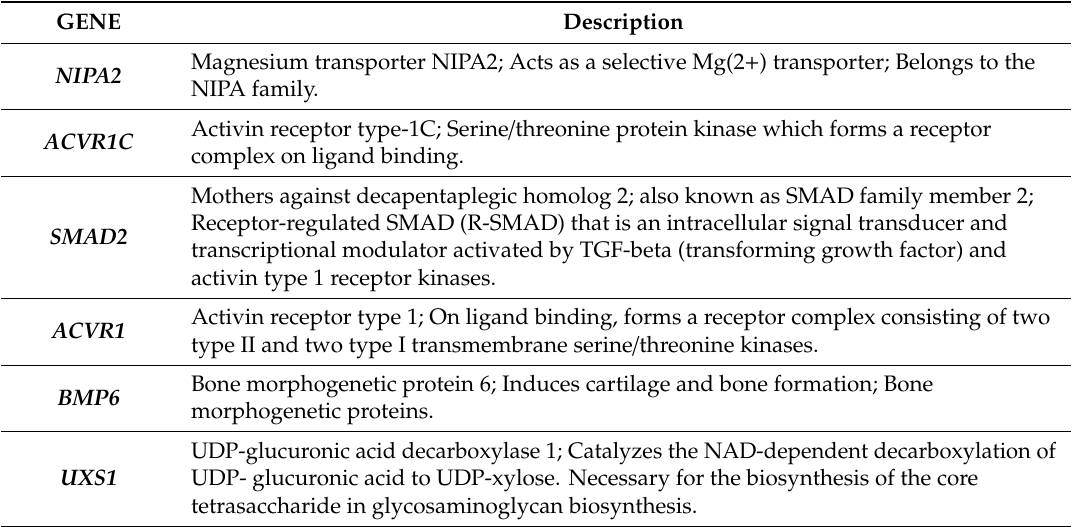
Table 8. STRING Protein Interactants and Their Functions for NIPA2.